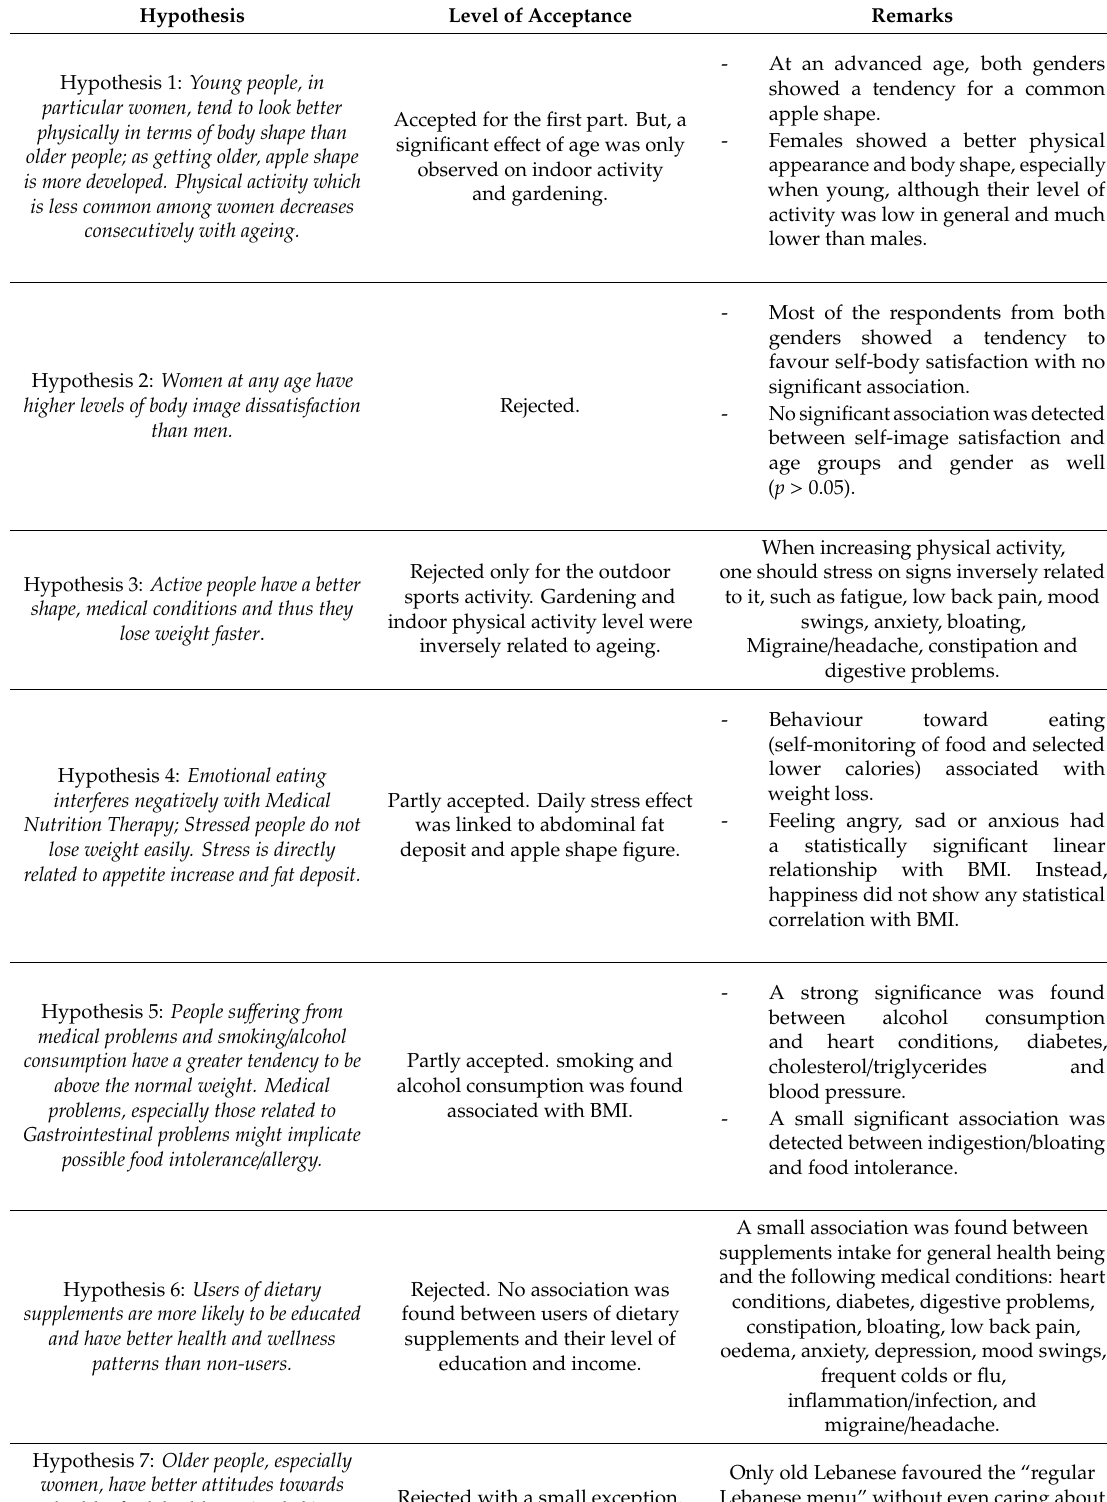
Table 2. Summary of the seven hypotheses with their results in terms of